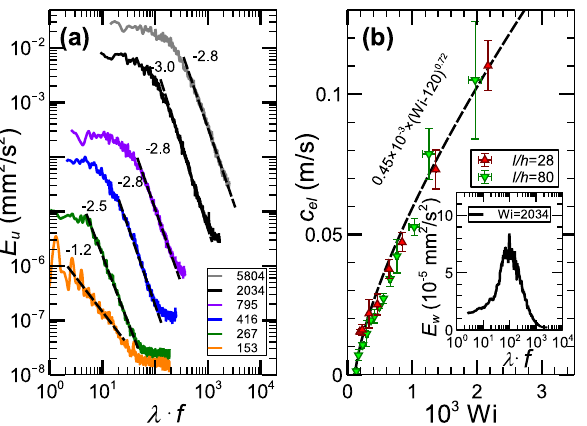
each moment is measured at the channel center. The energy spectra E u are plotted for different Wi in a different color presented in the plot. ( b ) Elastic wave propagation speed c el versus Wi at l / h =28 and 80 in lin-lin scales is fitted by a dashed line with the dependence on ( Wi − Wi c ) presented on the plot. The inset shows a peak of value of E w is the intensity of elastic waves that is equal to the square amplitude of the elastic waves.